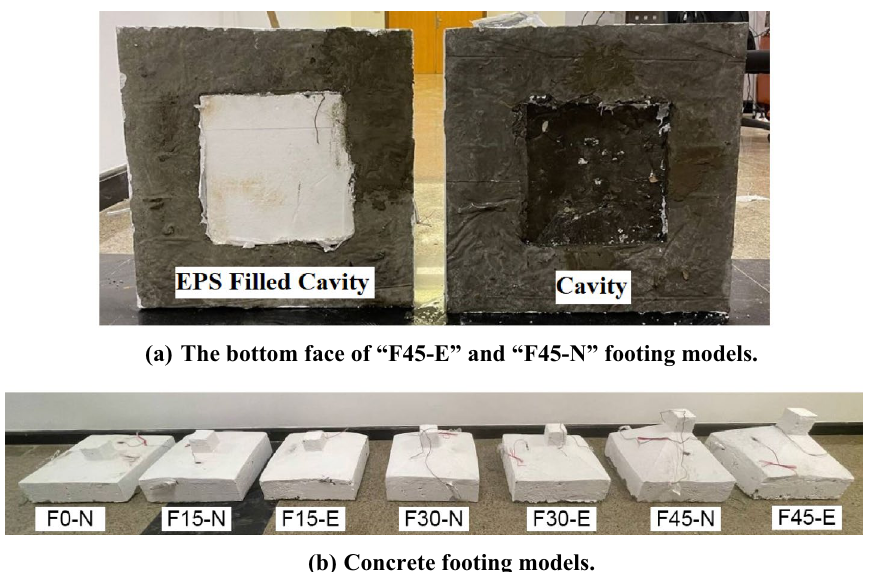
(b) Concrete footing models. Fig. 3 Photos showing the flat and folded footing models ( a ) bottom cavity, and ( b ) overview on all